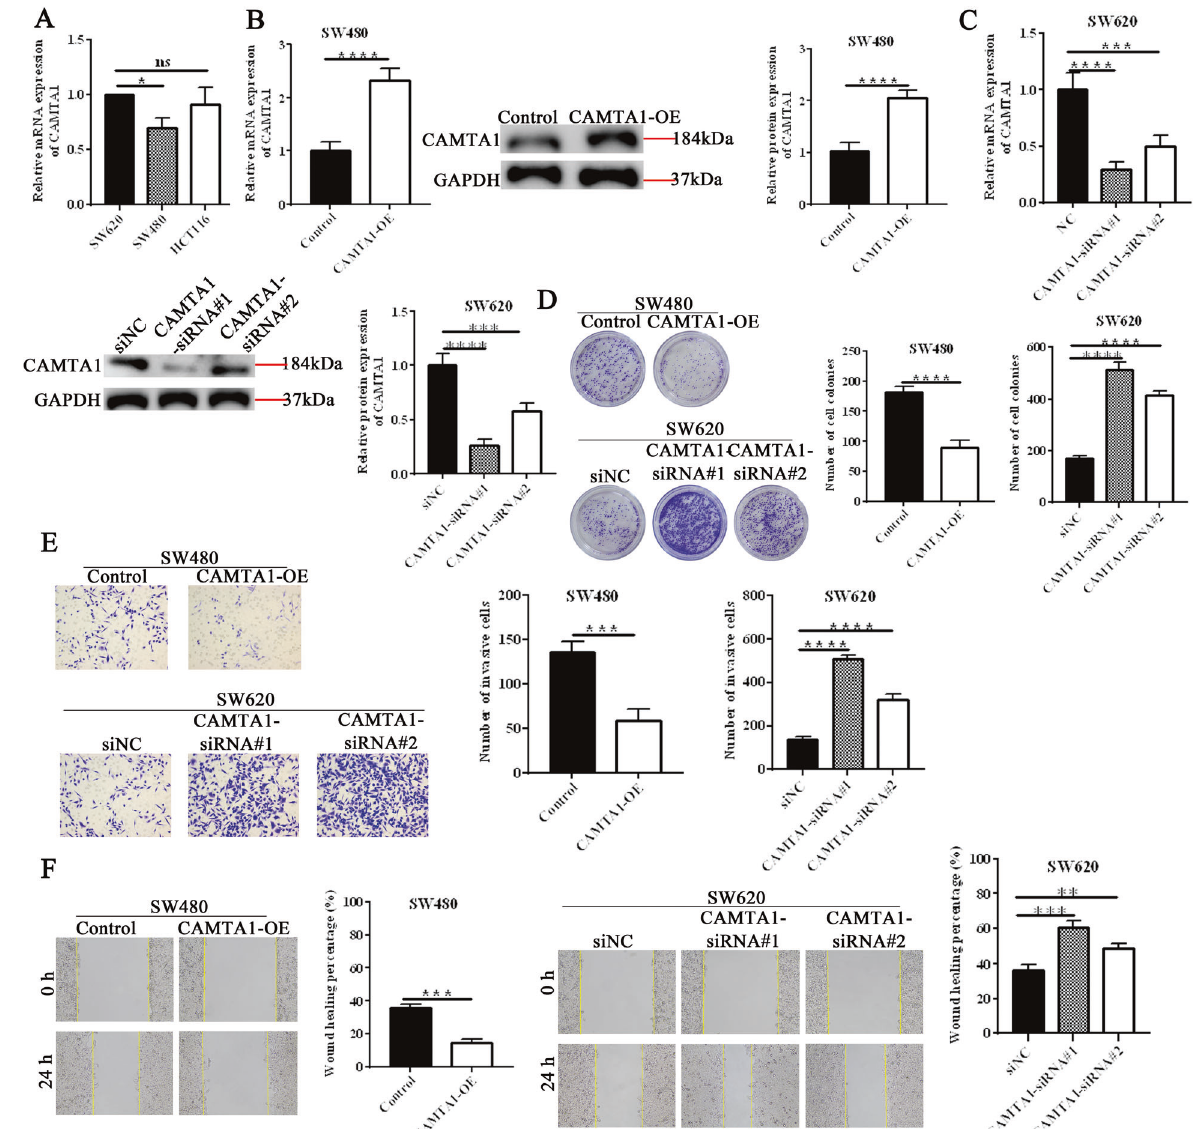
Fig. 2 CAMTA1 knockdown promotes colorectal cancer cell proliferation and invasion in vitro. A qPCR analysis of the CAMTA1 mRNA level in different colorectal cancer cell lines. B CAMTA1 overexpression (OE) ef fi ciency in SW480 cells, as determined by qPCR (left panel) and western blotting (right panel) analyses. Transfection of an empty vector served as the control in overexpression experiments. GAPDH served as the internal control for data normalization. C CAMTA1 knockdown ef fi ciency in SW620 cells, as determined by qPCR (left panel) and western blotting (right panel) analyses. Transfection of a nontargeting siRNA (NC/si-NC) served as the control, and two different siRNAs (siRNA#1, siRNA#2) were used for CAMTA1 knockdown in RNAi experiments. D Colony formation assay results of the effects of CAMTA1 overexpression and knockdown on SW480 and SW620 cell proliferation, respectively. Graphs (right panels) summarize results from three independently- performed experiments. E Migration assay results of the effects of CAMTA1 overexpression and knockdown on SW480 and SW620 cell invasion, respectively. Graphs (right panels) summarize results from three independently-performed experiments. F Wound healing assay results of the effects of CAMTA1 overexpression and knockdown on SW480 and SW620 cell migration at 24 h, respectively. Yellow lines represent regions where there were no cells. Graphs (right panels) summarize results from three independently-performed experiments. Data are presented as the mean ± S.E.M., n = 3. ns not signi fi cant; * P < 0.05; ** P < 0.01; *** P < 0.001; **** P < 0.0001 by one-way ANOVA, followed by Tukey ’ s HSD cells, while overexpression of CAMTA1 weakened this ability. In respectively. It was found by qPCR and western blot that CAMTA1 addition, overexpression of NFATc4 also enhanced the resistance negatively regulates the expression of NFATc4 (Fig. 5A, B, please of cells to oxaliplatin. Similarly, overexpression of CAMTA1 see Supplementary Materials for original western blot data). In weakened this ability. In SW620 cells, knockdown of NFATc4 order to clarify the role of NFATc4 in the oxaliplatin resistance of reduced the proliferation ability of cells, knockdown of CAMTA1 colorectal cancer regulated by CAMTA1, we conducted clone rescued the decrease of cell proliferation caused by knockdown of formation experiments and apoptosis detection respectively. NFATc4, and knockdown of CAMTA1 also rescued cells caused by Clone formation experiments showed that in SW480 cells, knockdown of NFATc4 decreased resistance to oxaliplatin (Fig. 5C). overexpression of NFATc4 increased the proliferation ability of